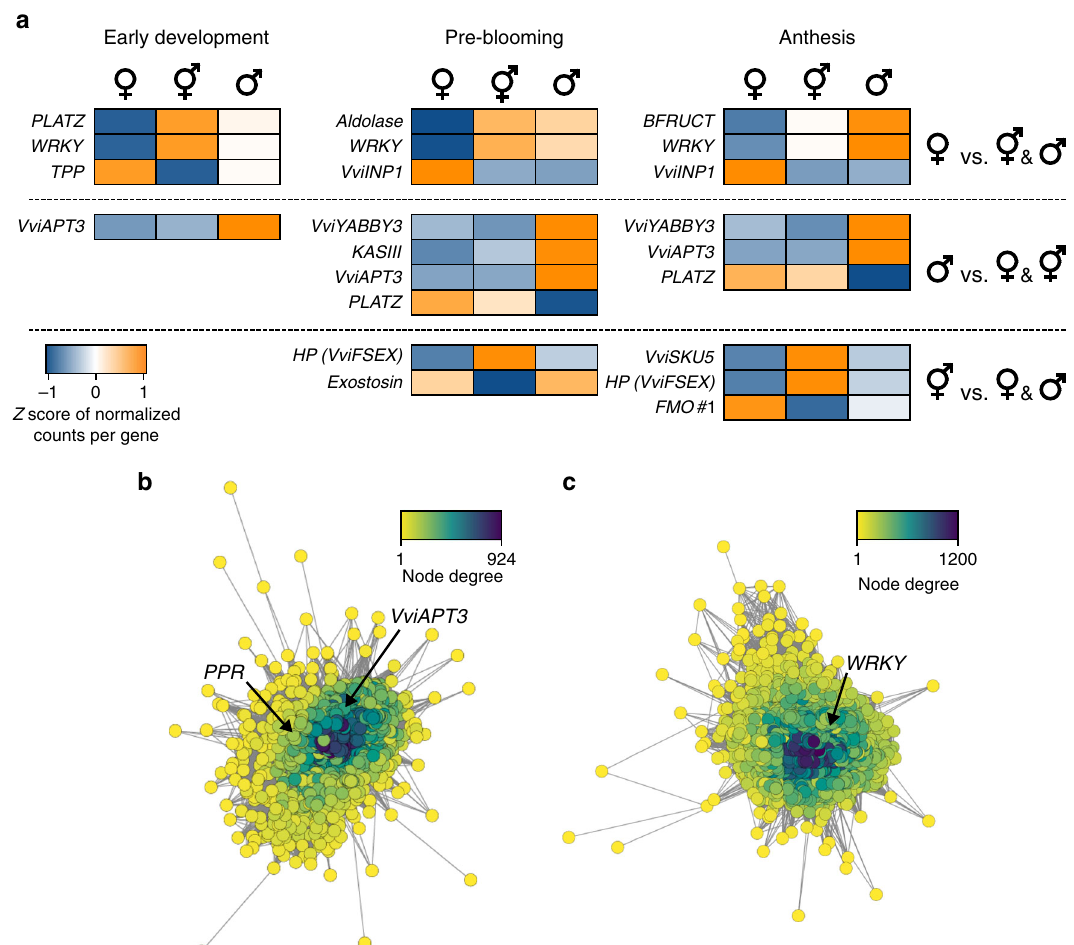
Fig. 5 Transcriptome and gene network analyses. a Sex-determining region genes have sex-linked expression at each fl oral stage. Genes are classi fi ed in three groups based on their expression pattern. Only genes differentially expressed in one fl ower sex compared to the two other sex types are shown. The colors of the heat map depict the Z score of the normalized counts per gene. Gene coexpression networks of the module magenta ( b ), positively correlated with male sex, and red ( c ), negatively correlated with female sex. Node color indicates the degree of connectivity in the network. Positions of the gene encoding a PPR-containing protein, VviAPT3 and WRKY in their corresponding networks are highlighted. HP hypothetical protein. Source data underlying Fig. 5a are provided as a Source Data fi